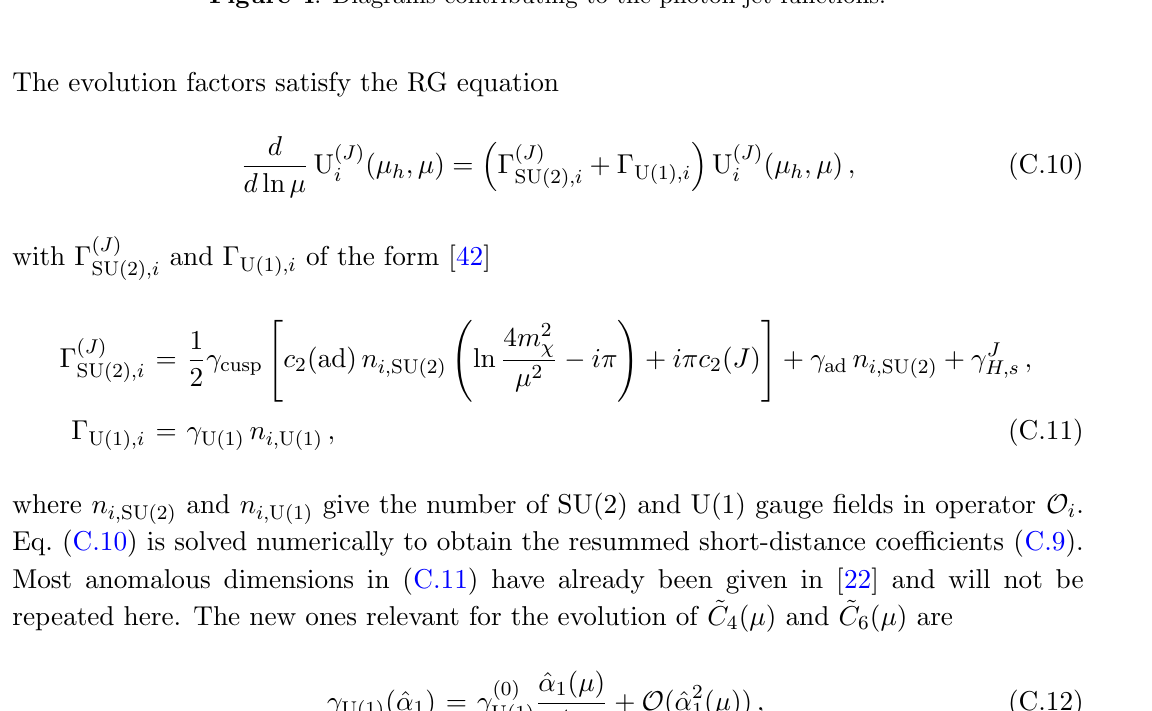
Figure 4 . Diagrams contributing to the photon jet